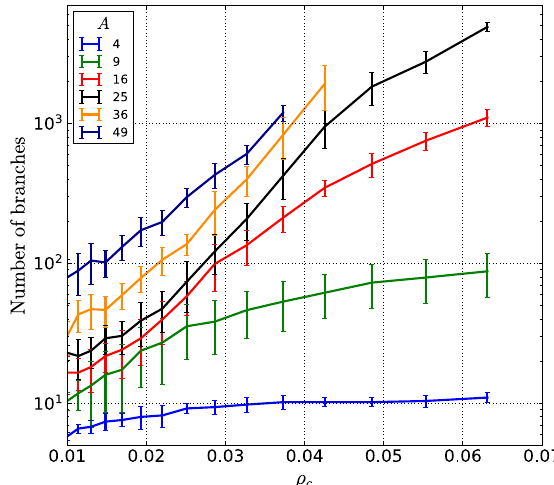
FIG. 8. Number of folding branches for patterns of different sizes, folded to magnitude ∥ ⃗ ρ c ∥ . At large folding angles, the same patterns have many more folding branches due to the lesser importance of face bending compared to stretching. In the main text, Fig. 4(a) shows vertical slices of the same data, illustrating the exponential size scaling of the branch number ( κ f ¼ 10 − 6